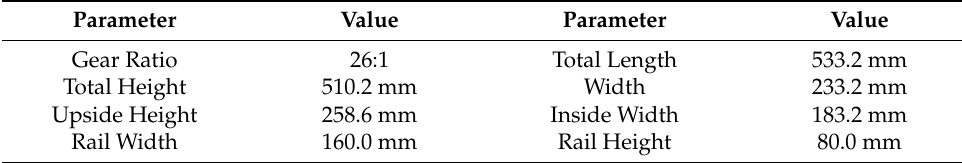
Table 1. Specifications of the overhang-type mover.